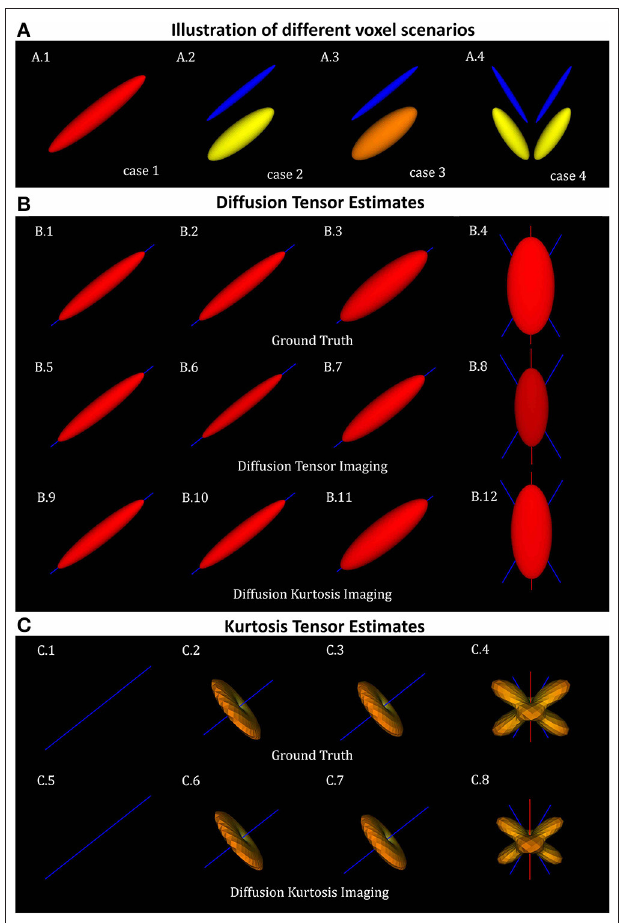
FIGURE 1 | Diffusion and kurtosis tensors from single and multi-tensor toy-models. (A) Illustration of the tensor components of each simulation case: (A.1) single tensor with AD and RD = 1.7 × 10 − 3 mm 2 / s and 1.3 × 10 − 3 mm 2 / s ; (A.2) mixture of collinear tensors with AD 1 , RD 1 , AD 2 , and RD 2 = 1.4 × 10 − 3 , 0.1 × 10 − 3 , 2 × 10 − 3 , 0.5 × 10 − 3 mm 2 / s (toy-model of a healthy fiber population); (A.3) mixture of collinear tensors with AD 1 , RD 1 , AD 2 , and RD 2 = 1 × 10 − 3 , 0.1 × 10 − 3 , 2 × 10 − 3 , 0.7 × 10 − 3 mm 2 / s (toy-model of a damaged fiber population); and (A.4) mixture of crossing tensors (toy-model of crossing healthy fiber populations). (B) Diffusion tensors for each voxel simulation: (B.1–B.4) Ground truth diffusion tensors; (B.5–B.8) diffusion tensors computed from DTI fit; and (B.9–B.12) diffusion tensors computed from DKI. (C) kurtosis tensors for each voxel simulations: (C.1–C.4) Ground truth kurtosis tensors; (C.5–C.8) Kurtosis tensors fitted by DKI. In this